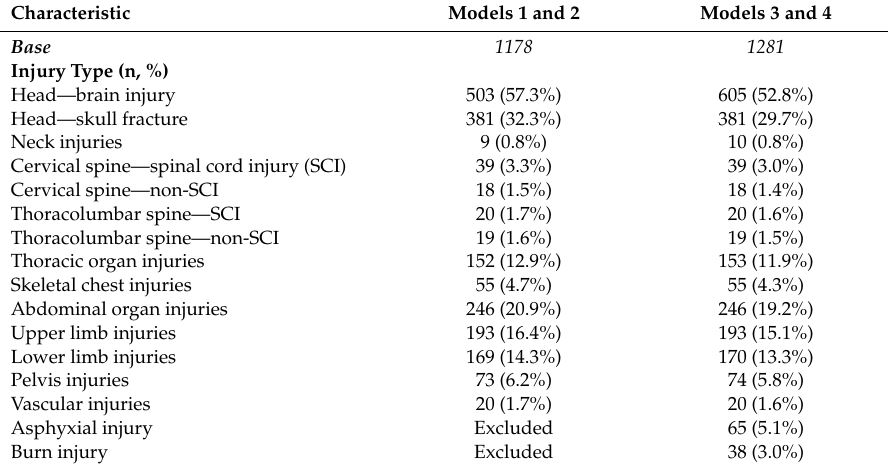
Table 2. Patient injury